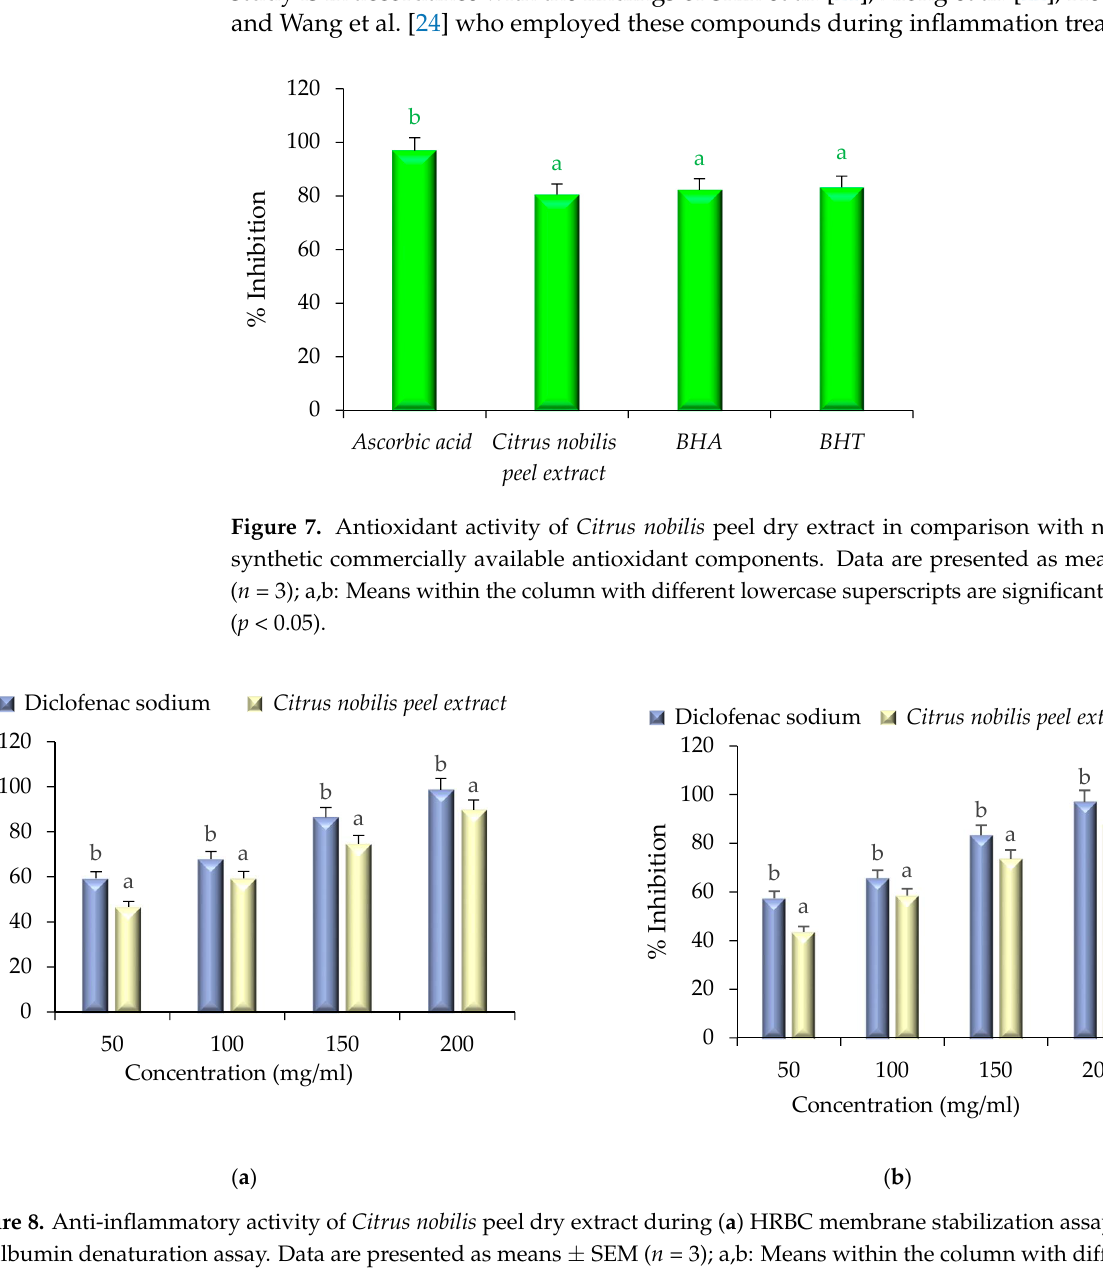
Figure 6. Total phenol, flavonoid, ascorbic acid content, total β -carotene, and lycopene content of